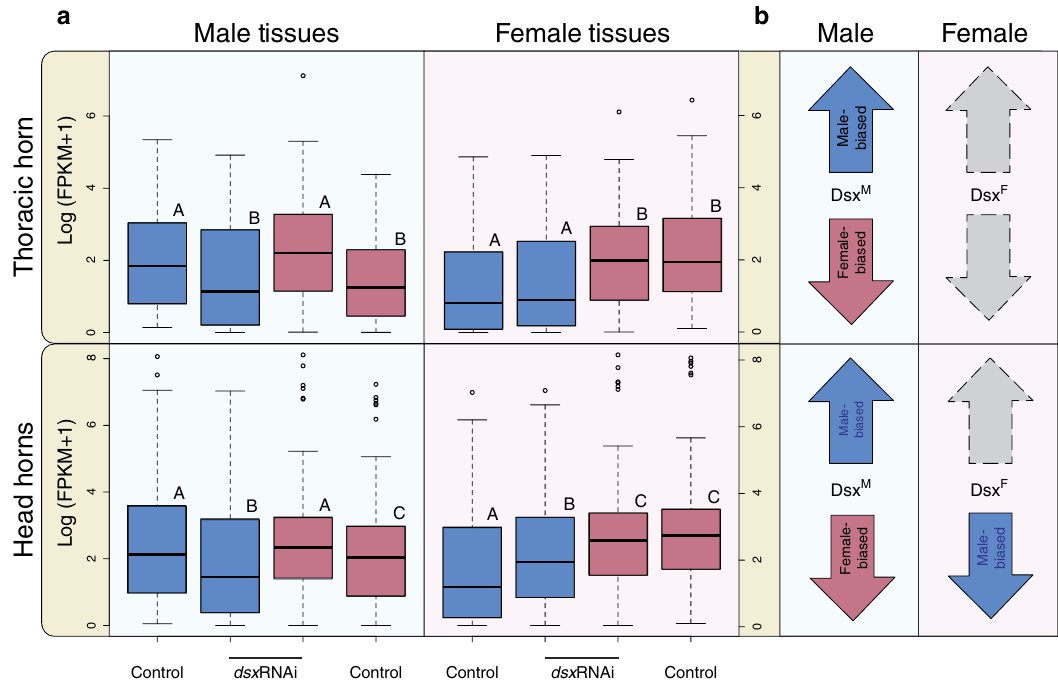
Figure 3 | dsx RNAi affects male- and female-biased gene expression in a sex-specific and tissue-specific manner. Dark blue and pink represent genes with male- and female-biased expression, respectively, as determined by comparisons between control males and control females. Background colours indicate whether those genes were assessed in male (light blue) or female (light pink) tissues. Letters indicate significant differences between levels of gene expression (Wilcoxon test and Benjamini–Hochberg correction for multiple comparisons). ( a ) In all male tissues assessed (thoracic and head horns pictured here, brain and genitalia in Supplementary Fig. 2), dsx RNAi decreased levels of male-biased gene expression (dark blue) and increased levels of female-biased gene expression (dark pink). In most female tissues (thoracic horn pictured here, brain and genitalia in Supplementary Fig. 2), dsx RNAi neither decreased levels of female-biased gene expression nor increased levels of male-biased gene expression. However, uniquely in female head horns (pictured here), dsx RNAi resulted in increased levels of male-biased gene expression. Lines within boxes are median values of gene expression and whiskers extend to the most extreme data points that are not outliers. Outliers—data points greater than (the upper quartile þ 1.5 (cid:2) the interquartile range) or less than (the lower quartile (cid:3) 1.5 (cid:2) interquartile range)—are represented as circles. ( b ) A summary of the differential actions of male and female Dsx isoforms among tissues; blue arrows indicate the effect on genes with male-biased expression, pink arrows indicate the effect on genes with female-biased expression and grey arrows indicate the absence of an effect. These results show that the male Dsx isoform modulates sex-biased gene expression across several male tissues, but that female Dsx isoforms typically only modulate male-biased gene expression in a single female tissue: head